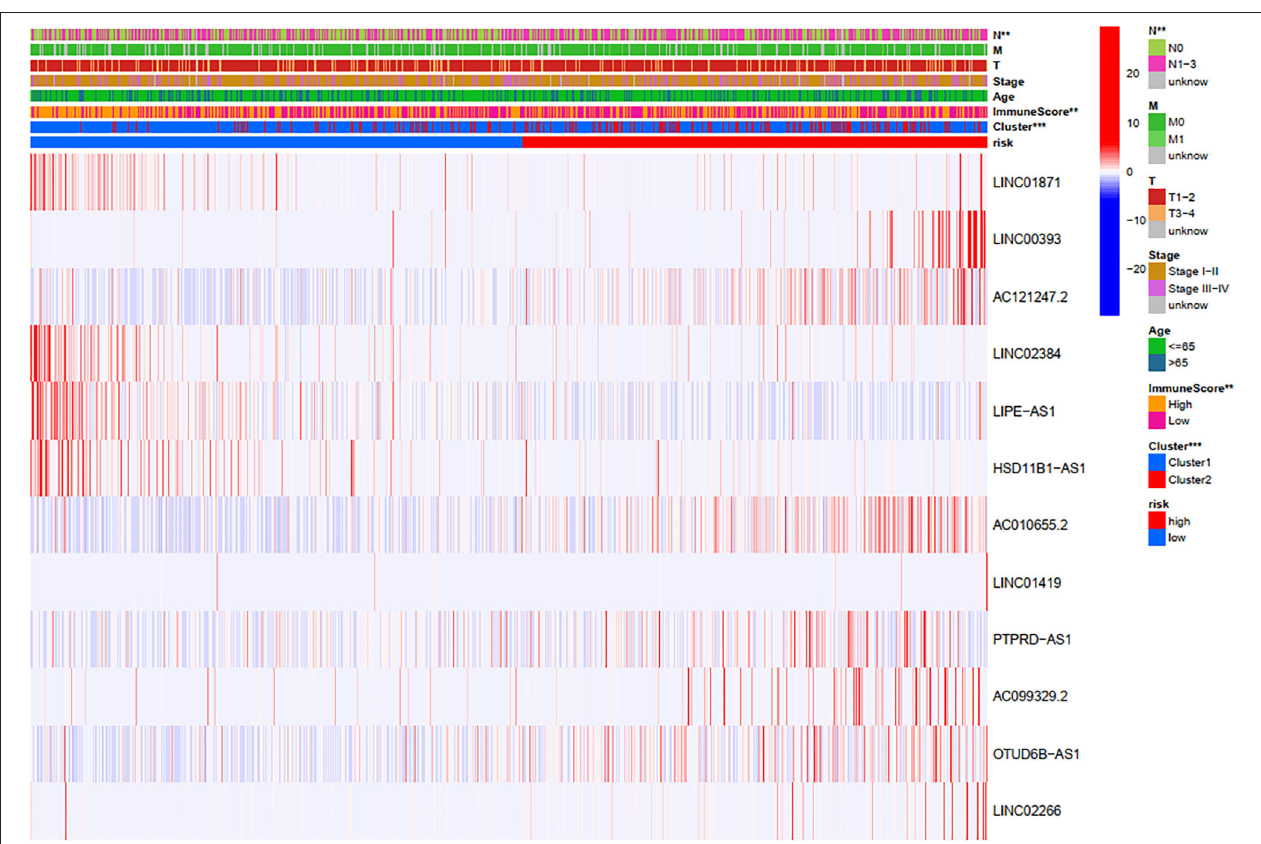
FIGURE 13 | Comprehensive analysis of the differences between the high- and low-risk groups.